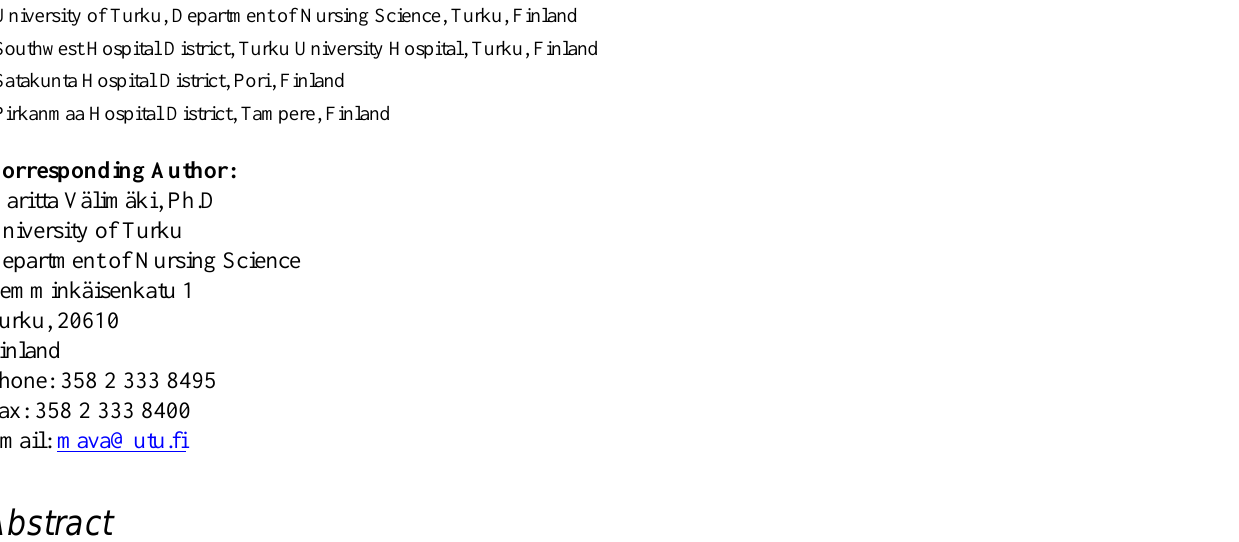
adolescent, Internet, depression, development, intervention,